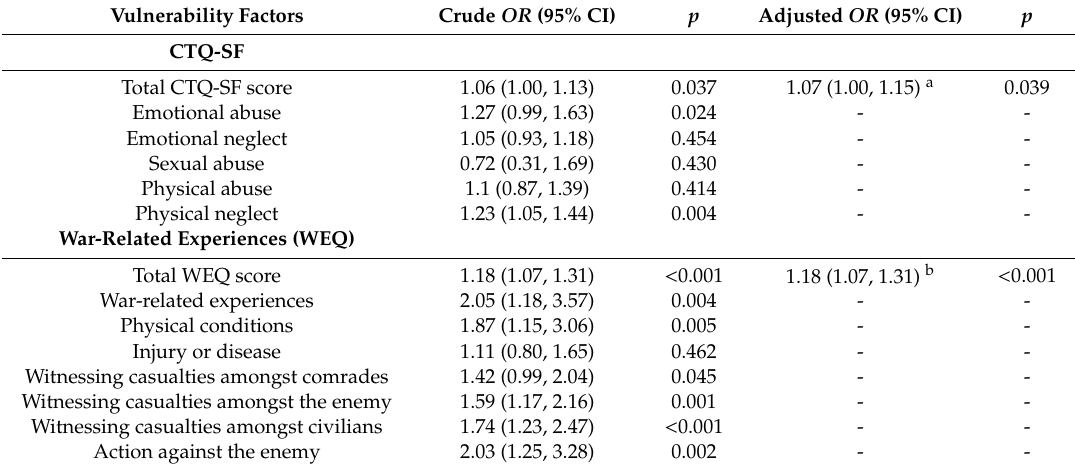
Table 3. Vulnerability factors for lifetime posttraumatic stress disorder development.